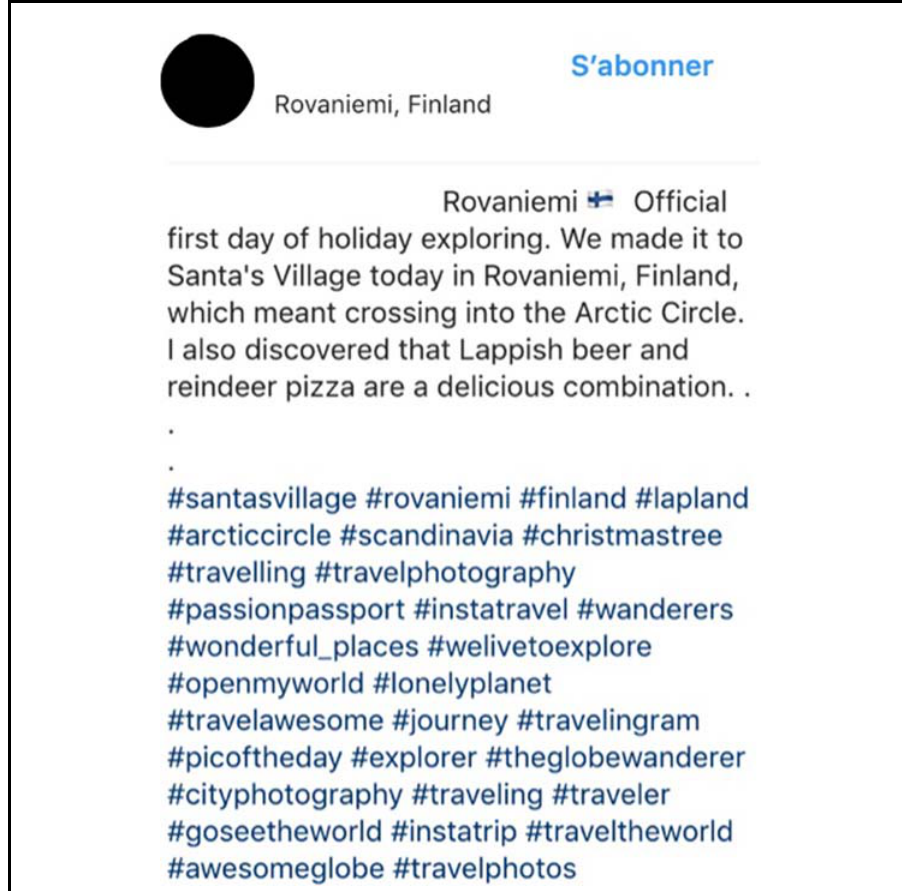
Figure 2 The Arctic Circle associated with Santa